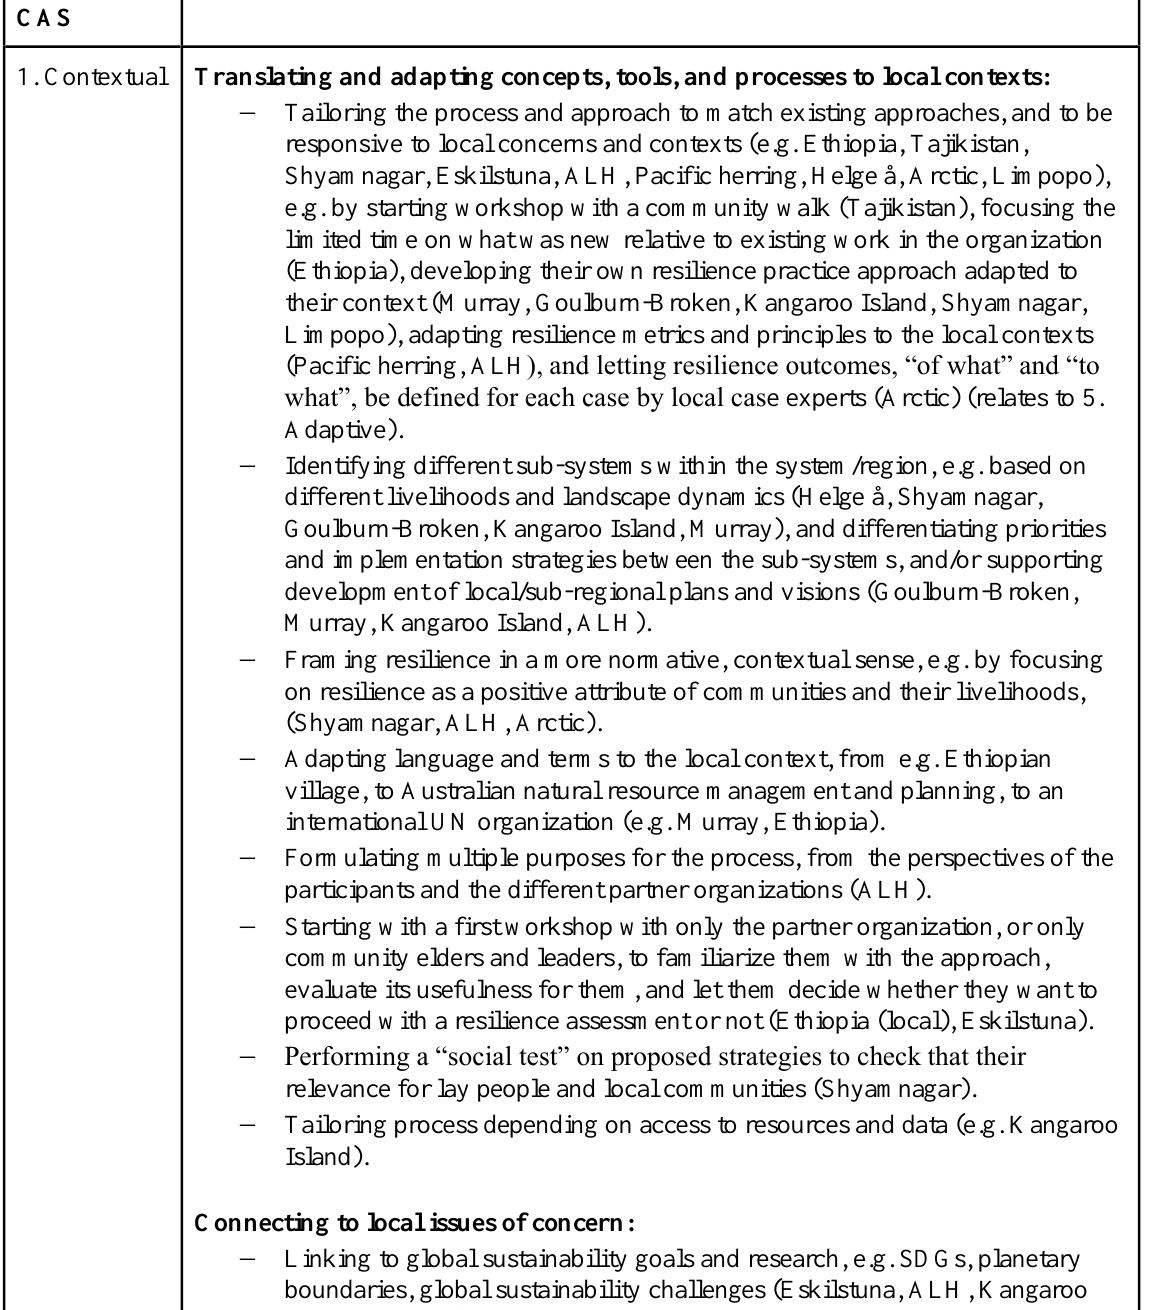
Table 3A. Strategies for engaging with complexity. Examples from the twelve cases included in this study (Table 2). Complexity is addressed through a framework of six features (Table 3). Features